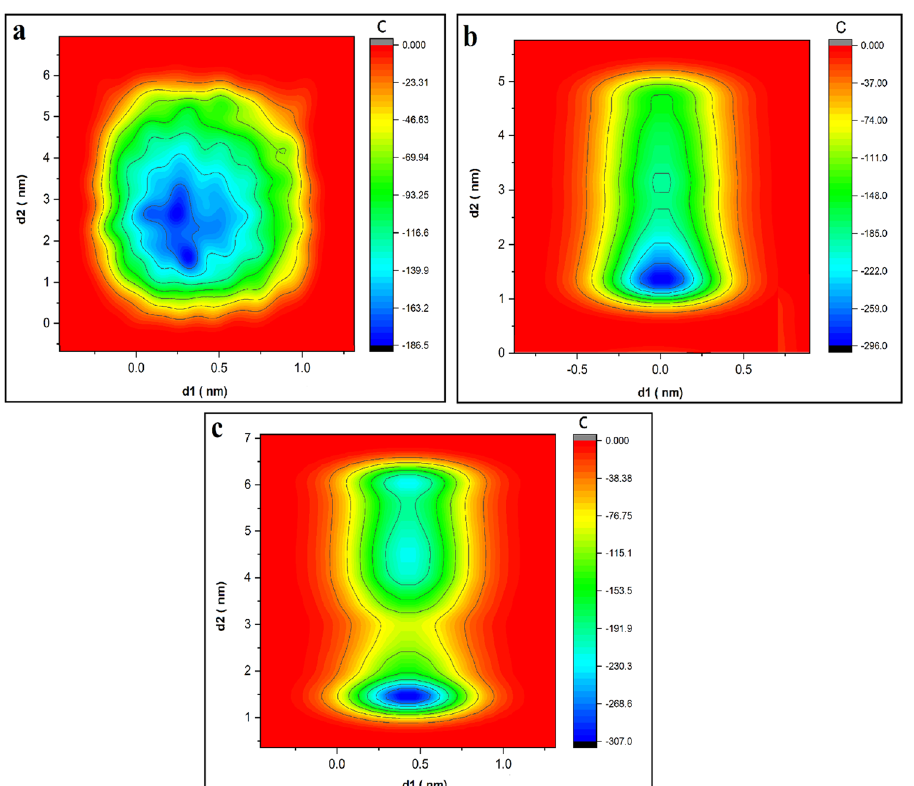
Fig. 8 FE landscape as a function of d1 and d2, which are the distance of the Rh B COM from the Cu-BTC/MOF COM and functional groups, respectively. a MOF-NH2, b MOF-OH, and c MOF-NO2 systems.